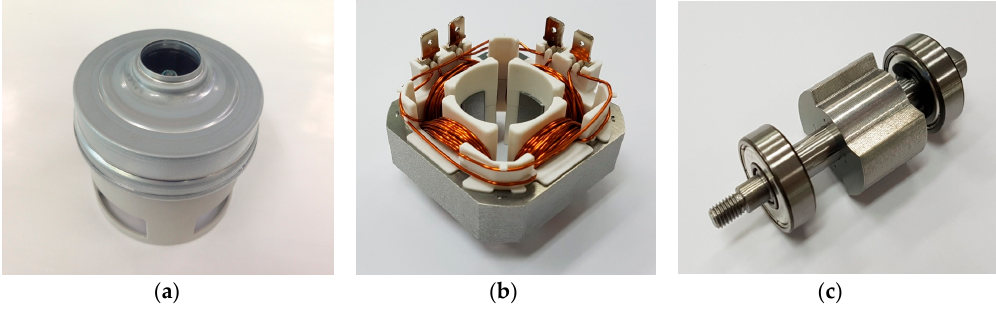
Figure 17. Prototype SRM. ( a ) Outside view of SRM prototype; ( b ) Structure of stator; ( c ) Structure of rotor.